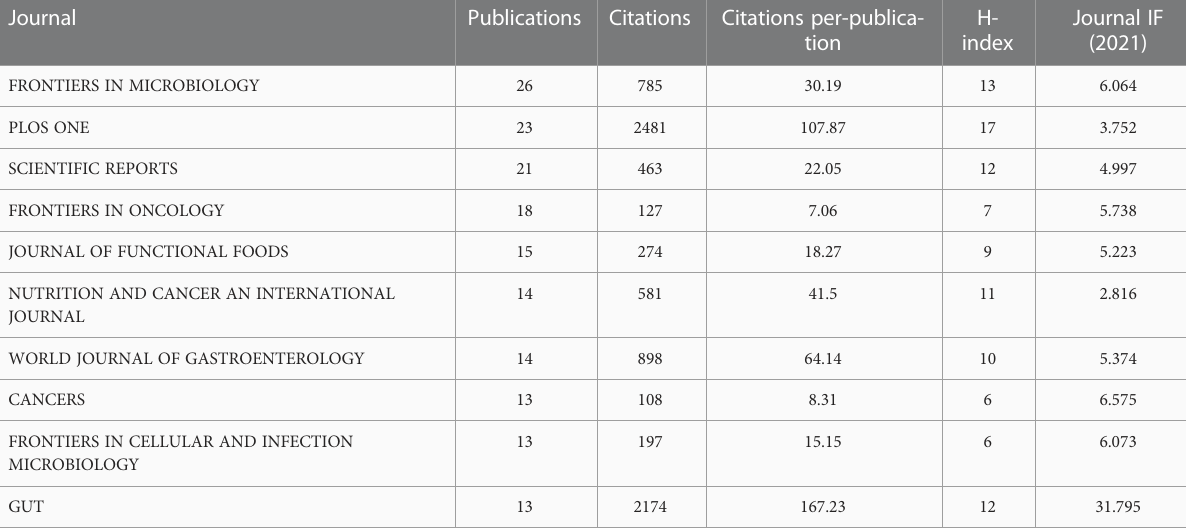
TABLE 1 The top 12 leading journals in the fi eld of microbiota and colorectal cancer research from 2001-2021.